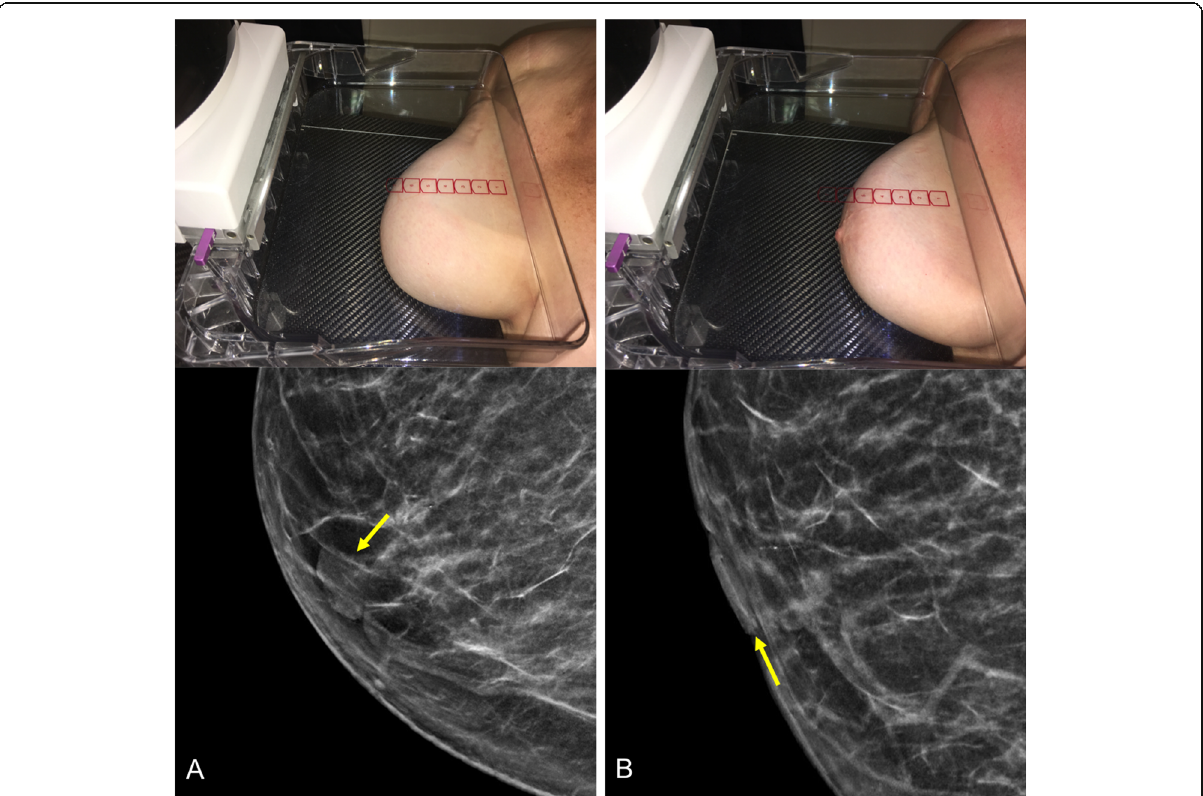
Fig. 6 Projection centered in the anterior region. A 56-year-old woman with voluminous breasts. a Craniocaudal 2D mammogram: the nipple is not tangential and is hidden in the lower part of the breast, producing a false image of a nodule (arrow). b Repeat craniocaudal view with the nipple